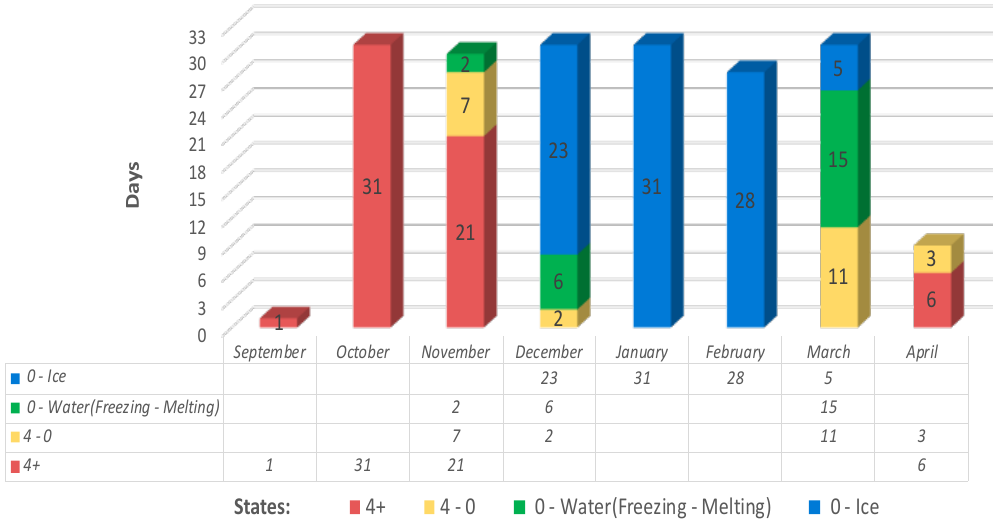
Figure 12. Ice storage states of t1—down position.